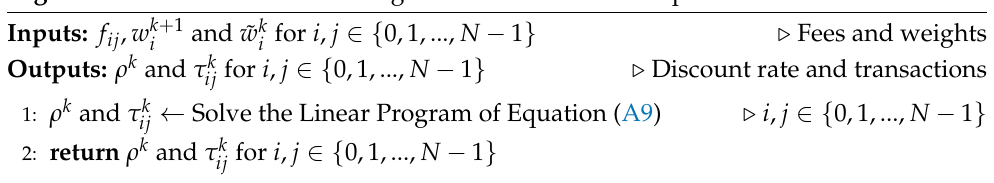
Algorithm 3 Exact solution for the general fee minimization